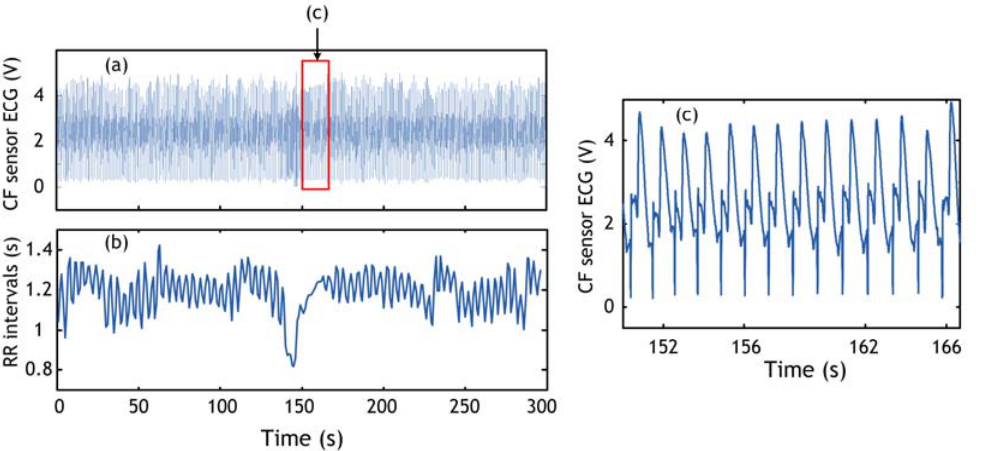
Figure 8. (a) ECG signal detected using conductive fabric sensor. (b) RR interval series calculated from (a). (c) Episode of ECG signal in the range of the rectangle shown in